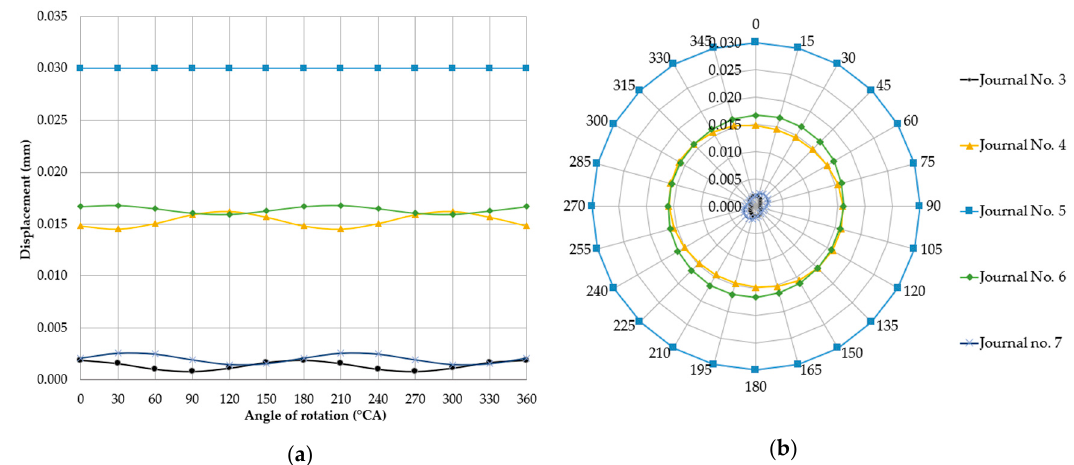
Figure 7. Changes in deflections measured in the vertical plane at individual main journals with the shaft rotated by 15° at a time and when one of the supports (of journal no. 5 counting from the timing gear end) is offset upwards by 0.03 mm relative to the others, shown in the charts in the ( a ) Cartesian and ( b ) polar coordinate systems.